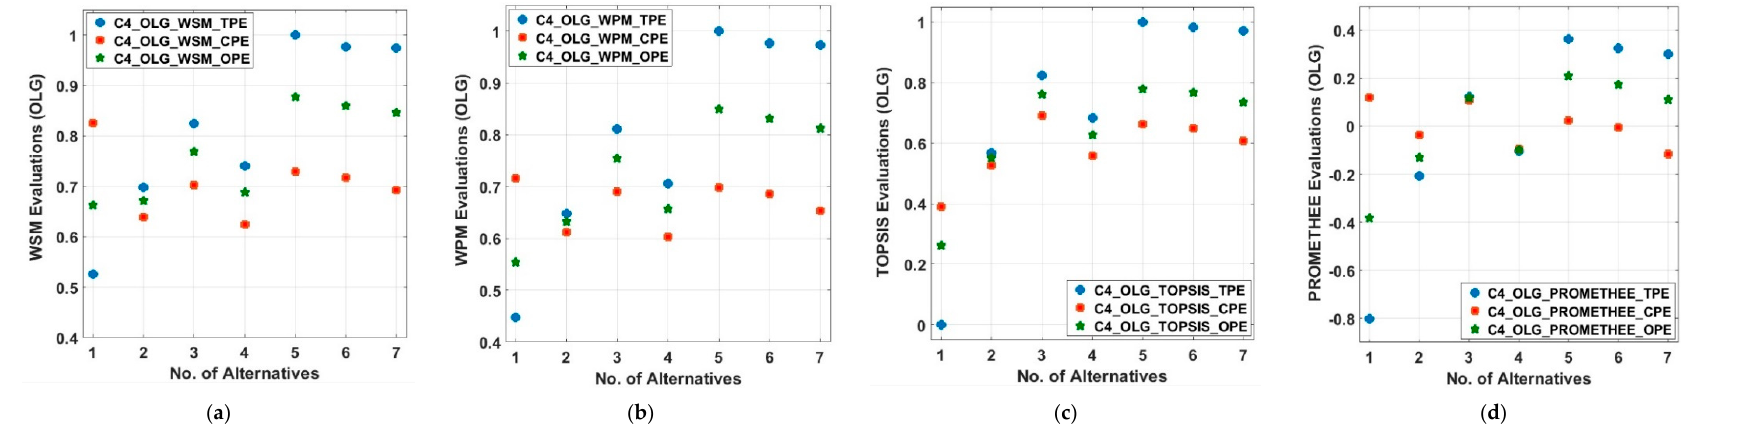
Figure 16. MCDM evaluations for C4_OLG in 33-bus MDN: ( a ) WSM scores; ( b ) WPM scores; ( c ) TOPSIS scores; ( d ) PROMETHEE scores. Table 28. Order of the ranks across TPE, CPE, and OPE in C4_OLG for 33-bus MDN.